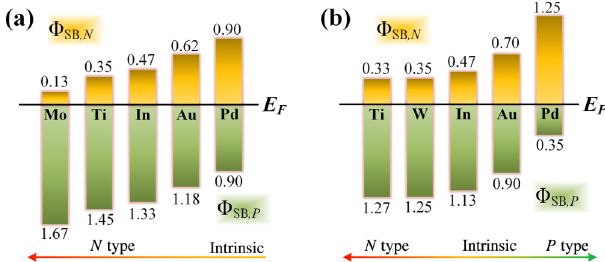
FIG. 14. Φ of all of the (a) MoS 2 top contacts and (b) WSe 2 SB top contacts. Φ ( Φ ) denotes n type ( p type) SB for SB ;N SB ;P electrons